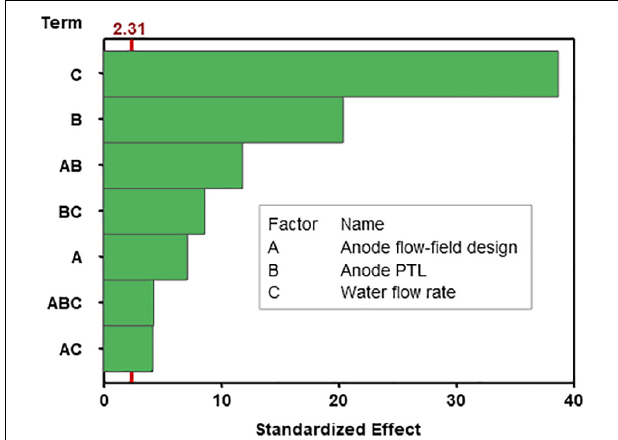
FIGURE 5 | Pareto chart showing the relative significance of the investigated factors and interactions on the response (cell potential). The red line indicates the significance level based on the α -criteria set at 0.05 (95% confidence level). If a bar crosses this line, the corresponding effect is deemed significant.